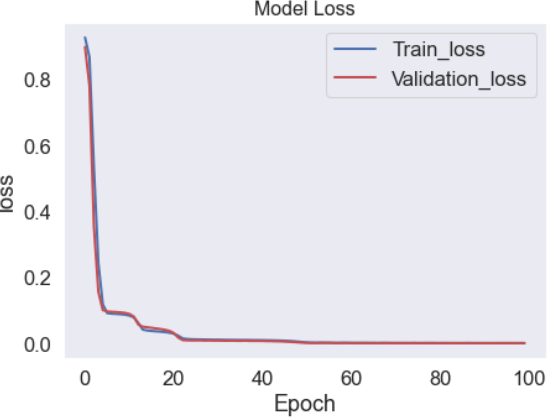
Figure 11. Training and validation Loss of the LSTM-autoencoder